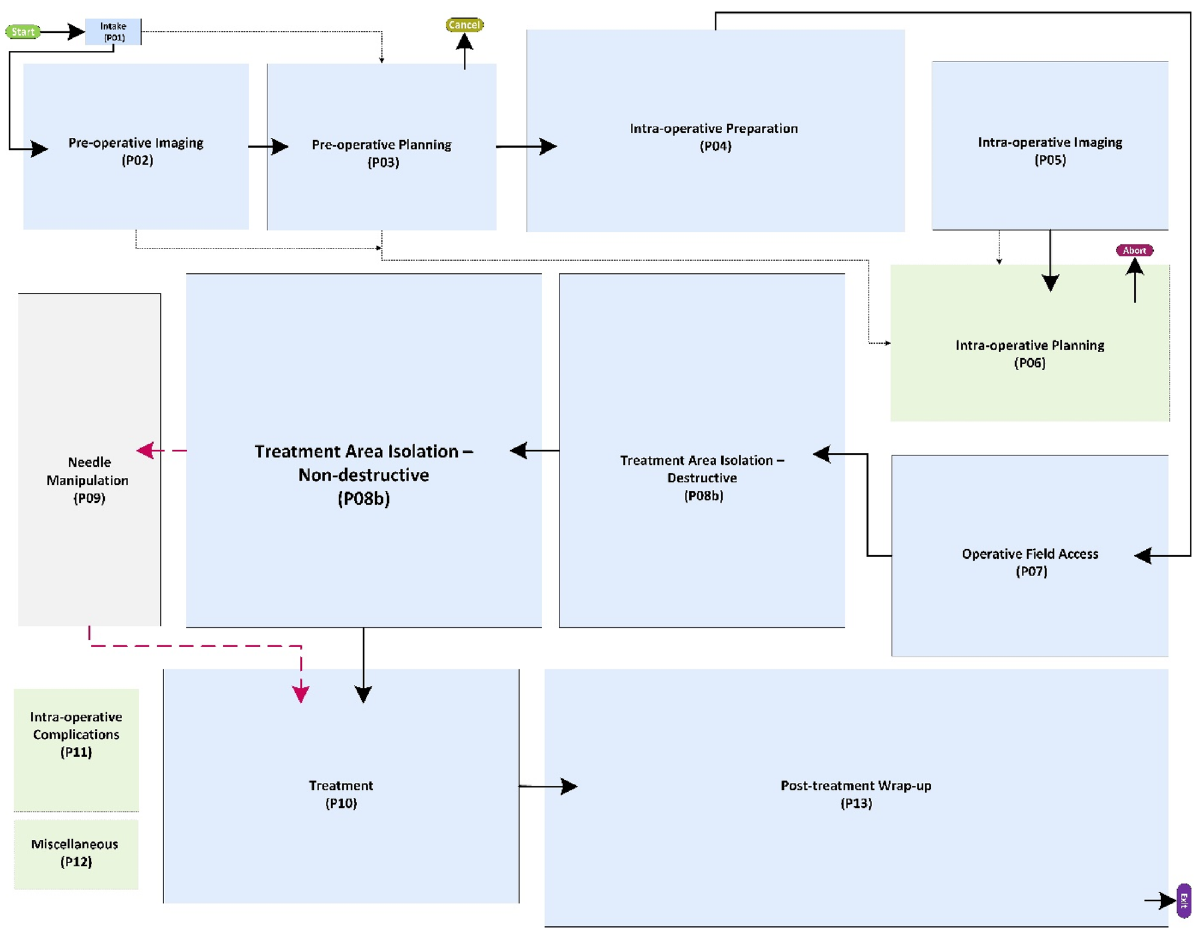
Figure 3. Generic process model of MILT at the phase level. Most of the phases are colored blue with solid- line rectangles; these phases are common between ablation and resection procedures. The gray phase, “needle manipulation”, is designated only for the ablation procedures. The blue and gray phases are connected by black solid and red dashed arrows showing the flow of activities. The black solid arrows are common between ablation and resection procedures, whereas the red dashed arrows are only used for ablation procedures. The green dashed rectangles show the phases that can happen anytime during the operation. These phases are connected to all other phases, but for the sake of readability, these arrows were left out of the figure. The black dotted-dashed arrows show the transfer of data such as medical images and patient medical